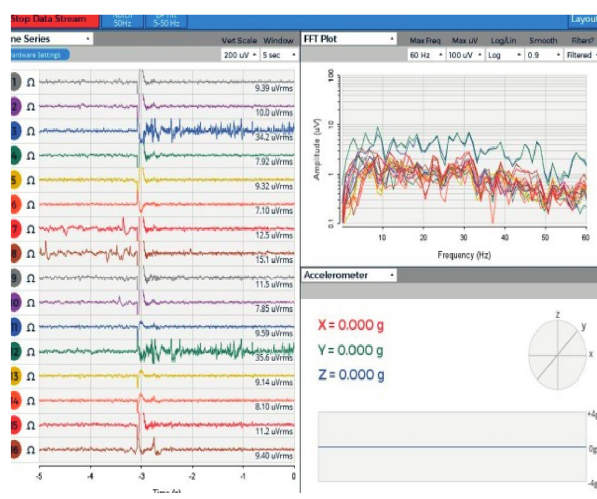
Figure 15: The EEG of shear action idea in the dynamic state.